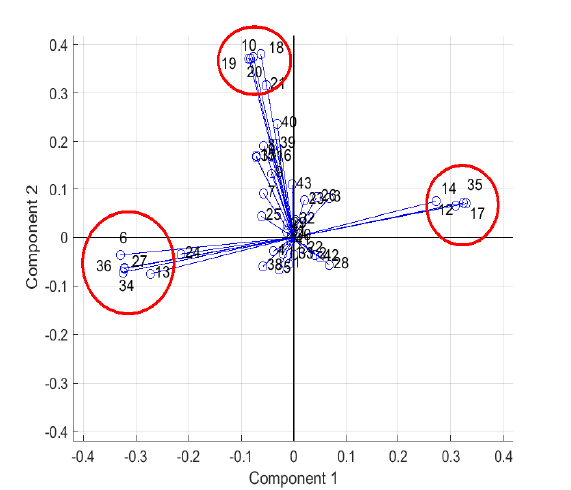
Figure 4. PCA on raw data: plot of Components 1 and 2 with clustered